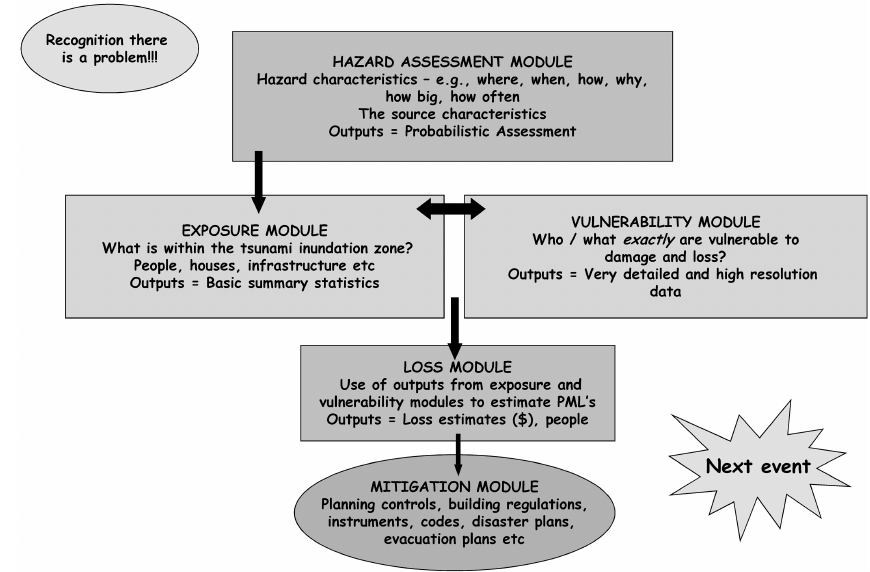
Fig. 1. The risk management process: a simplified flow diagram block indicating the main